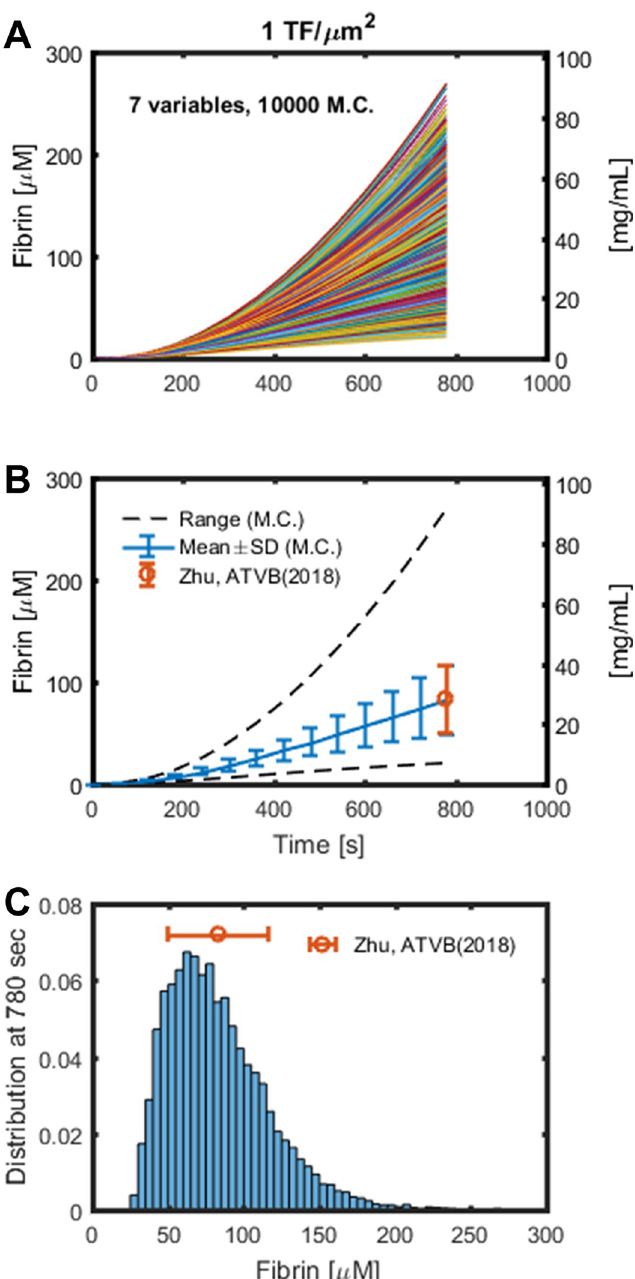
Fig 4. Fibrin concentration of 10,000 simulations compared to experimental data of blood clotting over collagen/ TF under venous flow rate. Fibrin concentration of 10,000 Monte Carlo simulations of 7 variables (A). The mean, standard deviation, range (B), and the distribution (C) of the simulations, with the experimental end-point estimation of fibrin concentration from the D-dimer ELISA (shown in red). The 7 variables of plasma protein levels and thrombin binding sites were generated uniformly and